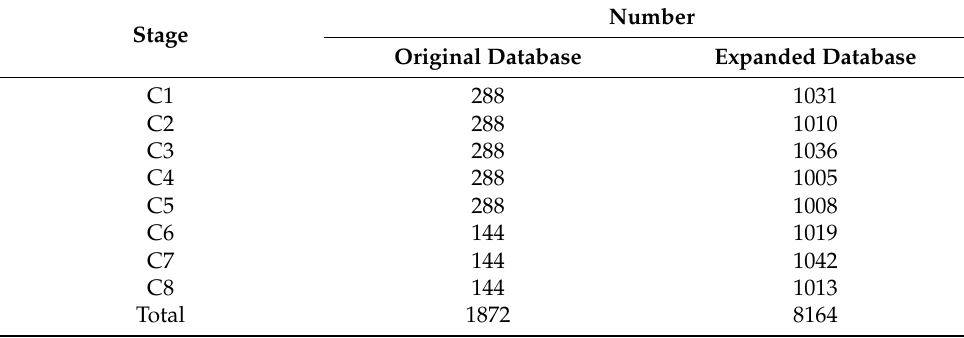
Figure 4. Examples of different augmented results. The isolated image above represents the original aspect. ( a ) Darkened image. ( b ) Overturned image. ( c ) Image after adding salt–pepper noise. ( d ) Brightened image. Table 1. Number of images from the original database and expanded database.